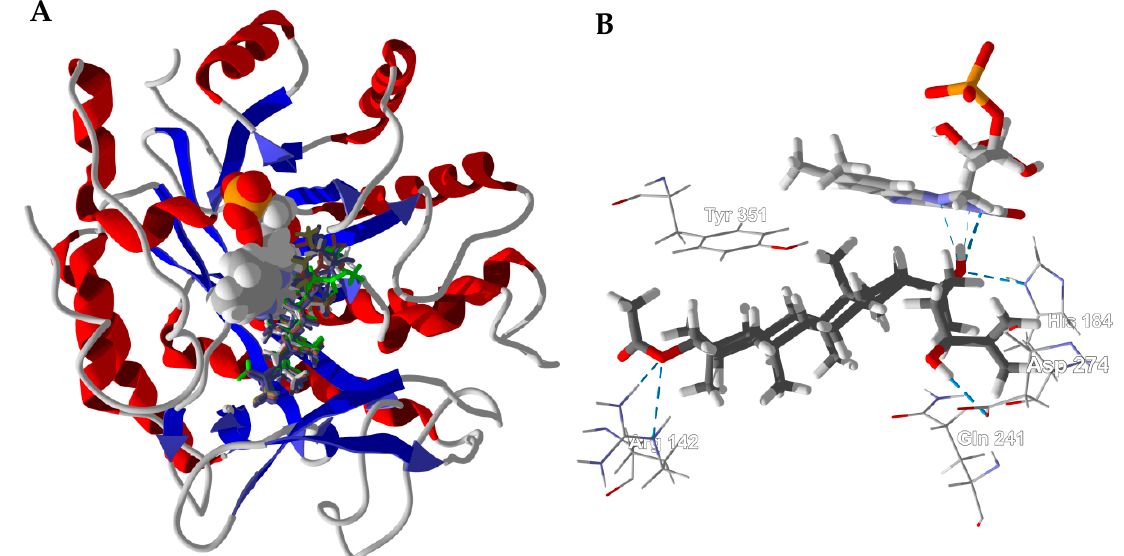
Figure 11. Enterobacter cloacae pentaerythritol tetranitrate reductase (EcPETNR, PDB 2aba). ( A ): Ribbon structure of EcPETNR with docked dammarane triterpenoids (stick figures). The riboflavin monophosphate cofactor is shown as a space-filling model. ( B ): Lowest-energy docked pose of 3 β -acetoxy-20 S ,24 S -dihydroxydammar-25-ene. Hydrogen-bonding interactions are indicated with blue dashed